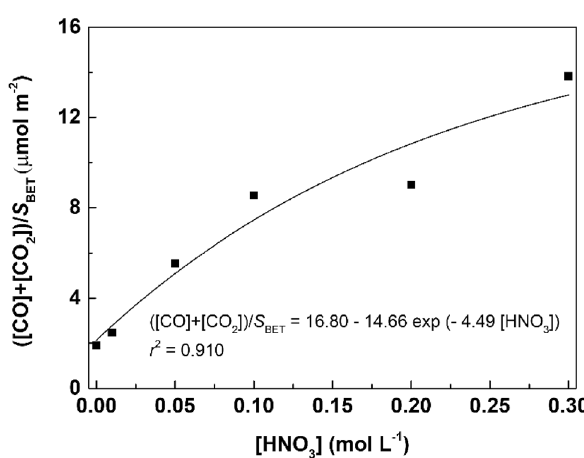
Figure 2. ( a ) Amounts of CO 2 and CO released by TPD, and ( b ) contents of volatiles and oxygen as a function of the concentration of HNO 3 employed in the hydrothermal treatment of CXs. Points represent experimental data, while lines represent non-linear fittings.